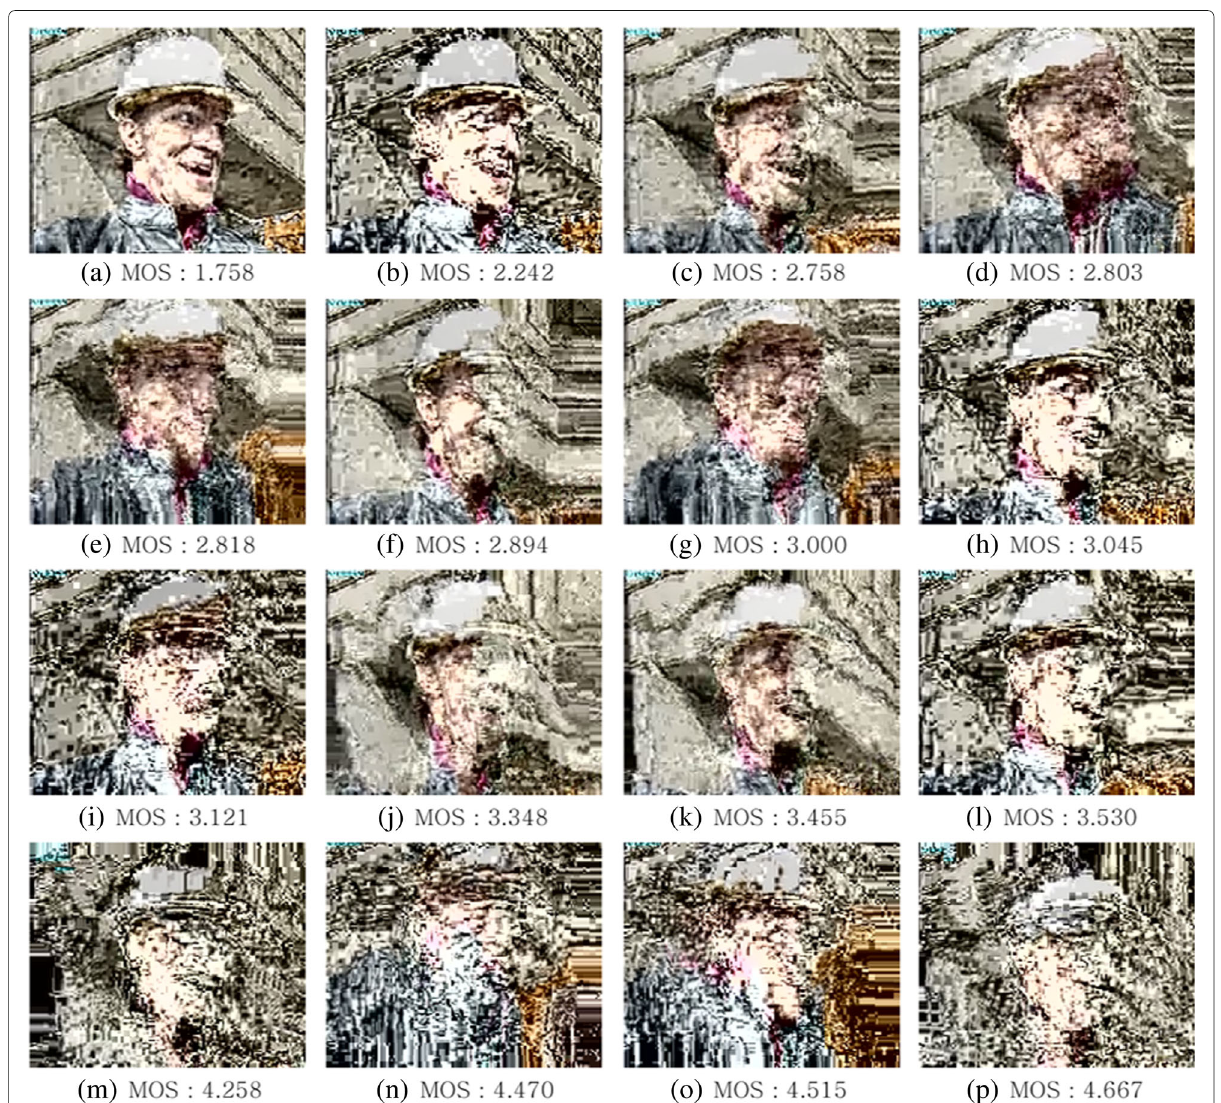
Fig. 5 a – p Each sample frame (131 st ) corresponding to each dot on the x -axis in Fig. 4. These figures show sample frames (131 st frames) and their scores from 66 subjects of all the videos evaluated in Fig. 4. Figure 5 presents the sample frames of different videos in the order of increasing MOS that is the subjective score, corresponding to the order of dots in terms of x -axis in Fig. 4. Accordingly, we like to claim that the STVSM which shows the most similar trend to increasing MOS appropriately captures the human eye’s perception for the encrypted videos